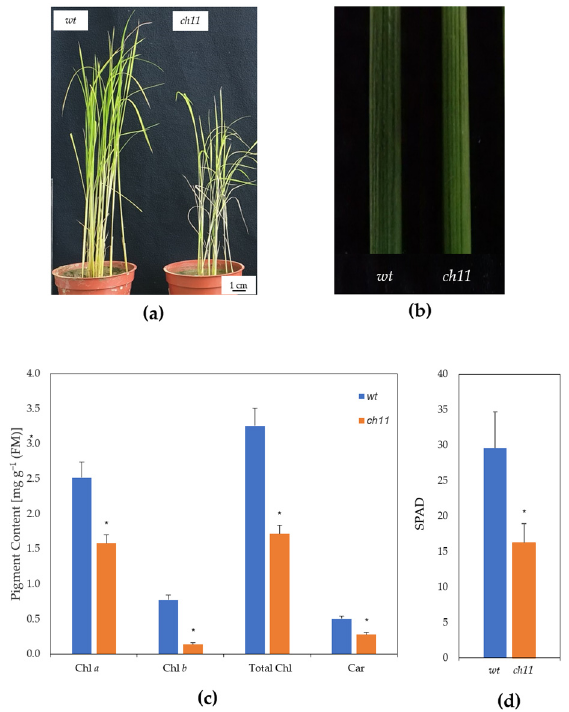
Figure 1. Plantlet phenotypes and assessments of leaf coloration and pigment contents. ( a ) Pheno- types of wild-type ( wt ) and chlorophyll b -deficient ( ch11 ) rice; ( b ) Leaf coloration of wt and ch11 rice; ( c ) Chlorophyll (Chl) and carotenoid (Car) contents of wt and ch11 rice; ( d ) Soil–plant analysis development (SPAD) values of wt and ch11 rice. Asterisks (*) indicate significant differences between the pigment contents of the wt and ch11 rice ( p ≤